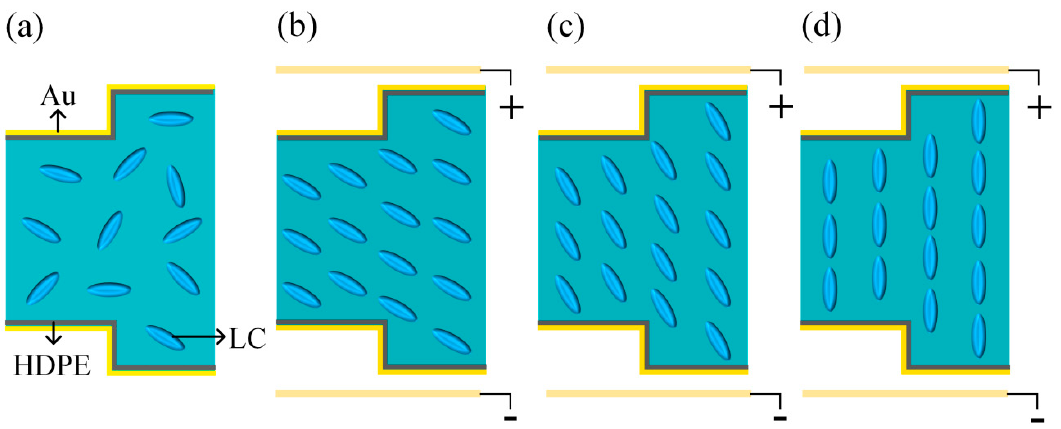
Figure 3. A schematic diagram of the LC (E7) molecule transition under an external electric field. The blue ellipses represent the LC molecules. ( a ) The molecules distribute randomly when there is no external electric field. ( b – d ) The orientations of LC molecules change with increasing electric field intensity.